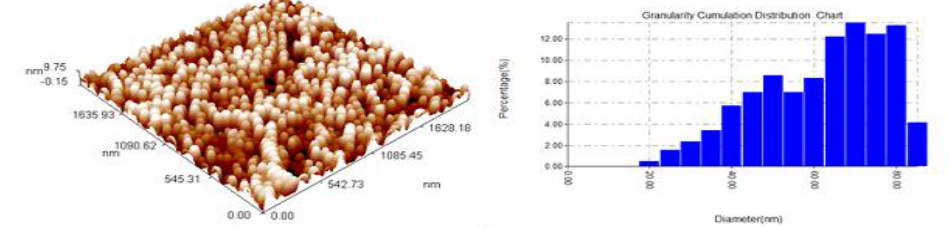
Fig.(a): AFM images for nanostructure at energy 200 mJ with (Avg. Diameter 59.34. nm).